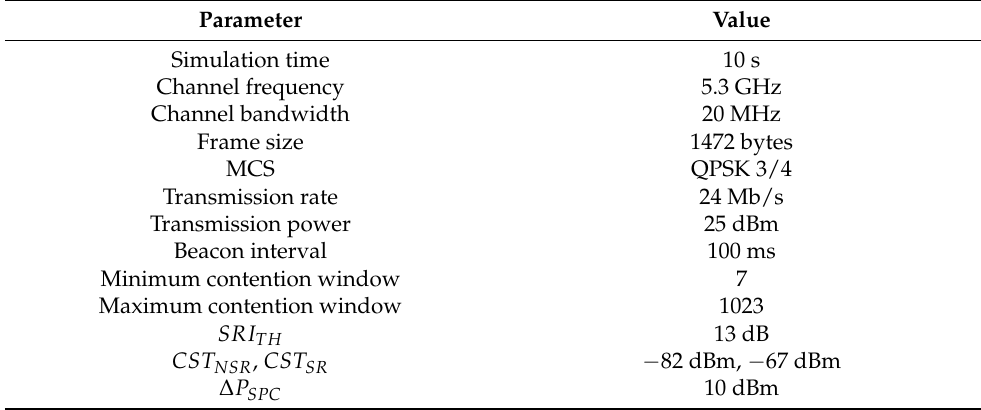
Table 1. Simulation parameters. Parameter Value Simulation time 10 s Channel